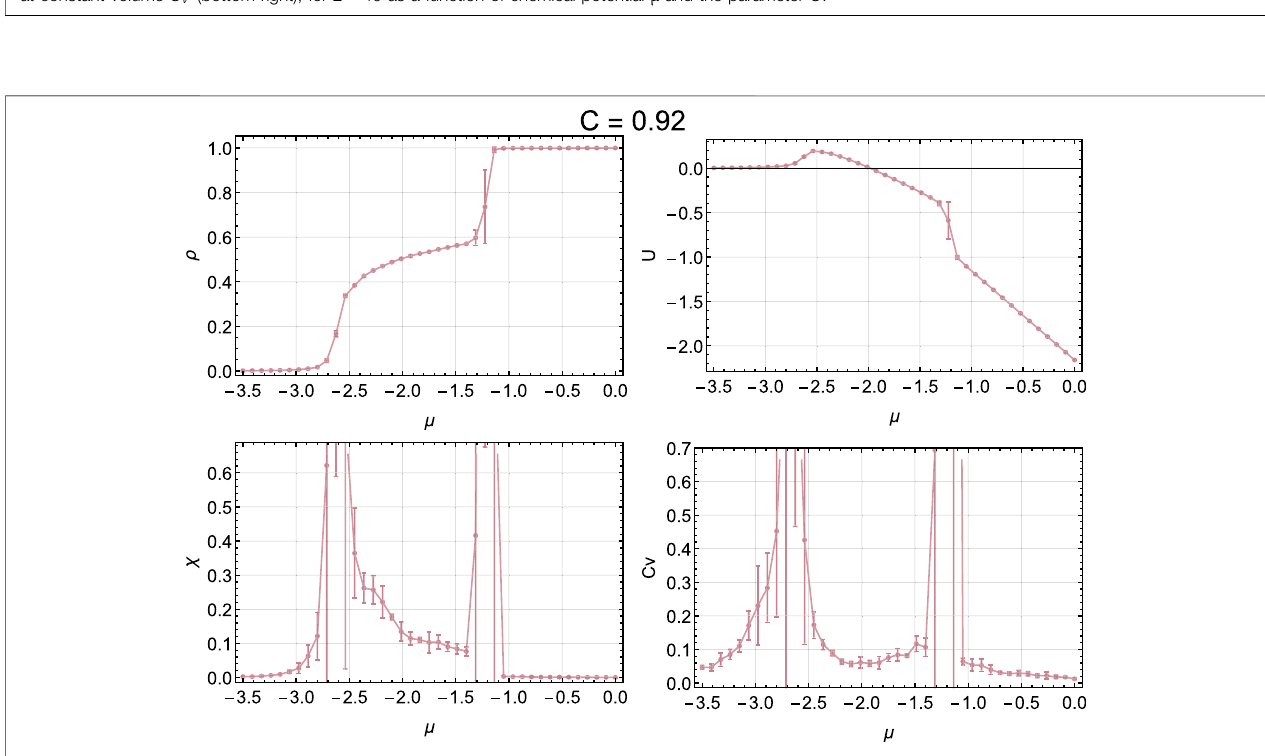
FIGURE 4 | Macroscopic variables for a square lattice: density ρ (top left), internal energy U (top right), density susceptibility χ (bottom left) and heat capacity at constant volume C V (bottom right) for constant C (cid:1) 0 . 92 for L (cid:1) 40 as function of μ . Dark line in U separates positive and negative energies.